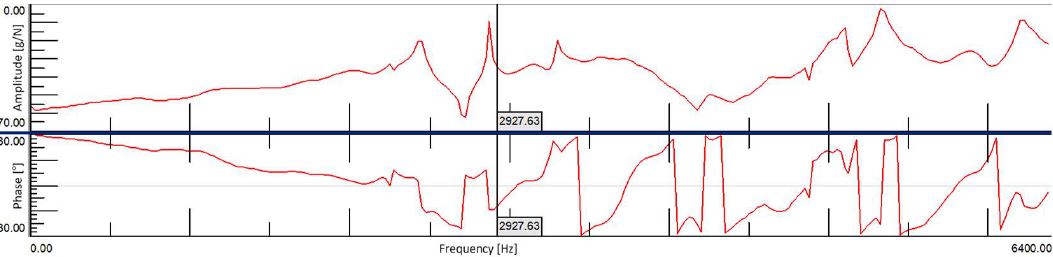
Figure 8. The theoretical first natural frequency of brick vibrations in the averaged FRF